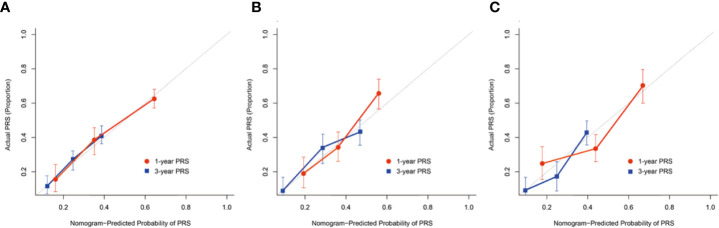
The calibration curves demonstrating how the 1- and 3-year post-recurrence survival predictions from the model compare to the actual observed survival in the (A) training, (B) internal, (C) external validation cohort.